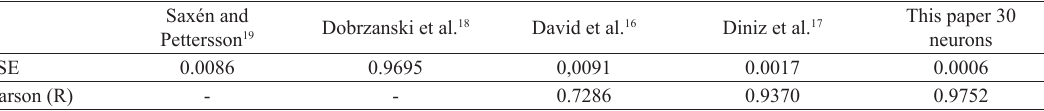
Table 15. Comparison between models reported in the literature 16-18